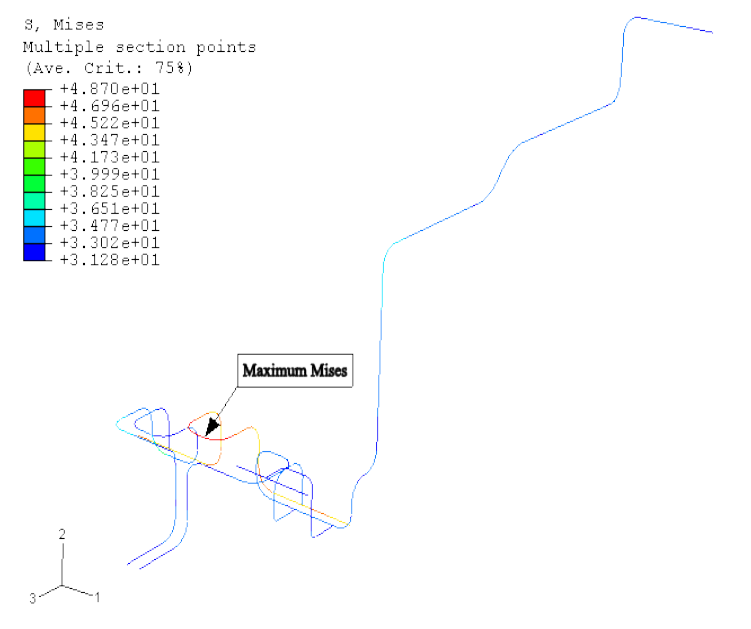
Figure 2. Von Mises stress contour of the piping system.